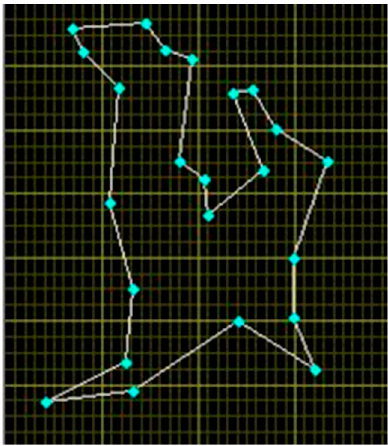
Figure 14. Optimal path generated for using one vehicle.